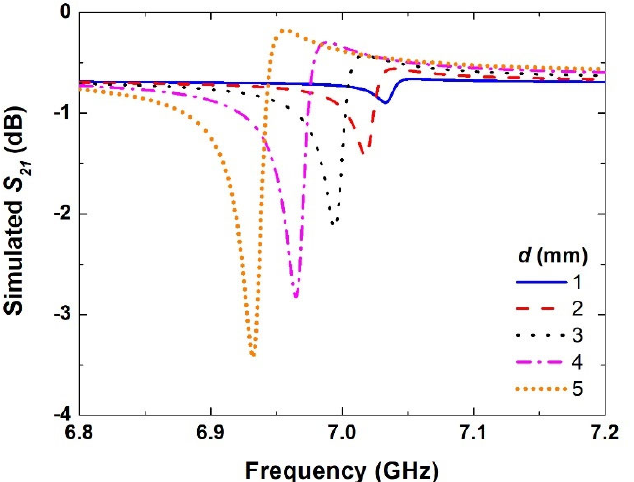
Figure 5. Simulated transmission amplitude coefficient ( S 21 ) of designed SRR structures at different asymmetric distances ( d ) from the center.